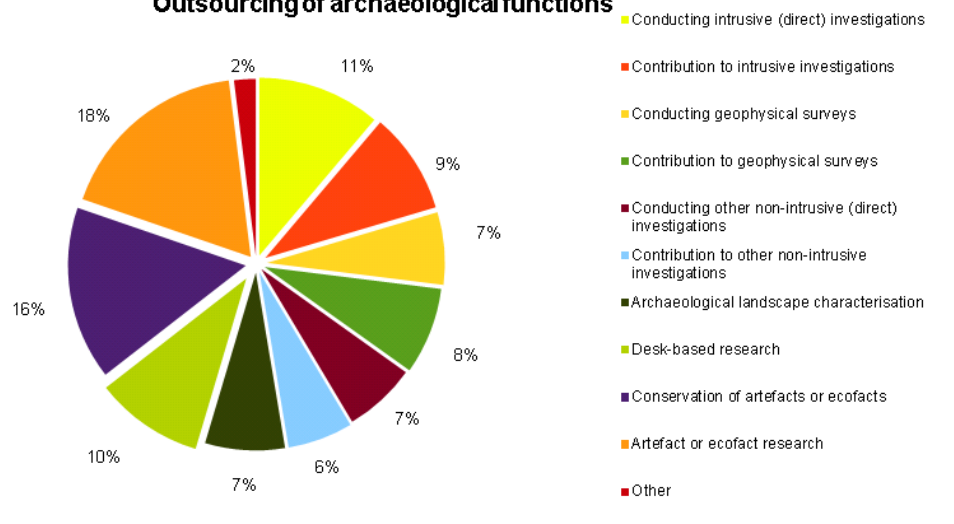
Figure 25 - Outsourced archaeological